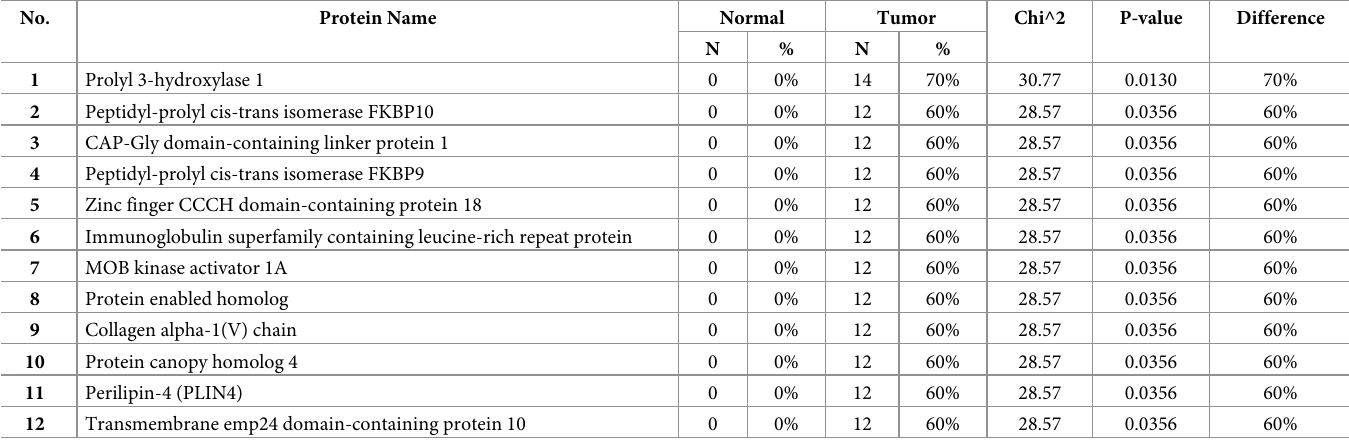
Protein profiling Table 2 shows the presence of 12 specific proteins that were identified and detected in stage 2 breast cancer tissues but not in normal tissues. Chi-squared values revealed significant results for 12 of these proteins ( P < 0.05). The list of proteins identified by LC-MS/MS, in stage 2 of breast cancer tissue and their details as shown in PEAKS Software (S2 Table and S3 Appendix). PEAKS provides a number of statistical charts for the peptide and proteins score distributions and Venn diagrams. The figures show the peptides and proteins score distributions, and the Venn diagrams show clearly the non- redundant unique and overlapping of the peptide and proteins numbers in both tumor and the adjacent normal breast tissues for the stages 2 and 3 (see S4 Appendix). Additionally, we found 17 proteins that were detected in stage 3 breast cancer samples com- pared to the normal samples (Chi-square values indicated significant results for all 17 proteins, P � 0.01) as revealed in Table 3 (S4 Table and S5 Appendix). Table 2. List of proteins detected in stage 2 breast cancer samples.